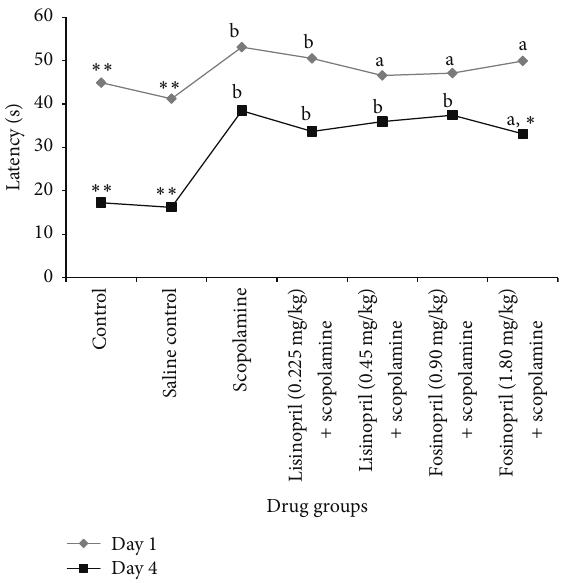
Figure 2: Effect of lisinopril and fosinopril in scopolamine-induced amnesic rats during the acquisition trials in Morris water maze test. Comparison between control, scopolamine, lisinopril, and fosinopril treated groups during the acquisition trials on day 1 and day 4 of Morris water maze test. Values are mean ± SE, ∗ versus scopolamine ( 𝑝 < 0.05 ), ∗∗ versus scopolamine ( 𝑝 < 0.001 ), a versus control ( 𝑝 < 0.05 ), and b versus control ( 𝑝 < 0.001